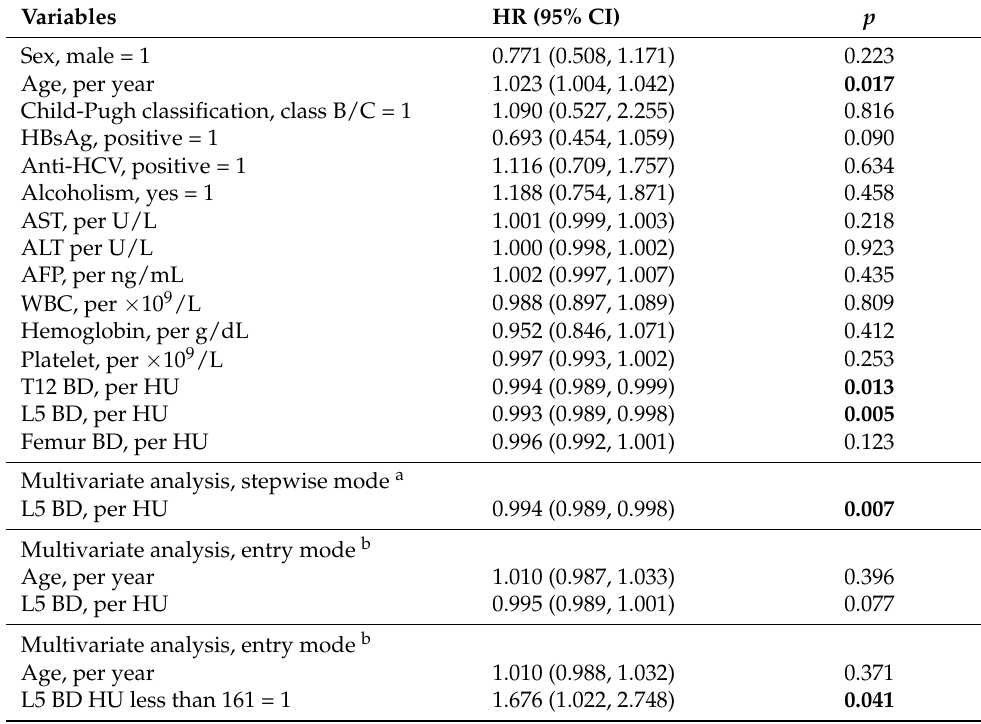
Table 4. Cox proportional hazard analysis for clinical factors in relationship to time-to-HCC occurrence.